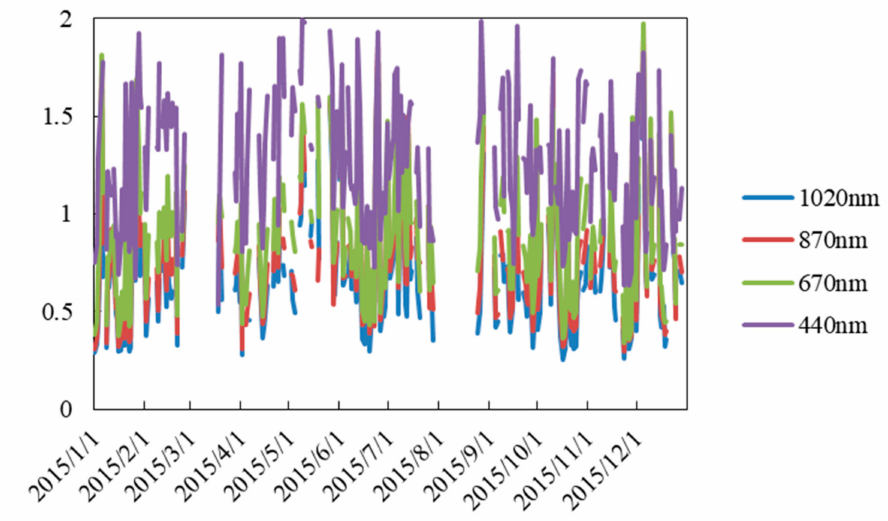
Figure 3. AOD from CE318 in 2015. We identified three components of aerosols from Guangzhou [42,43]: sea salt (SS), water soluble (WASO), and black carbon (BC). The extinctions of the components were derived from OPAC model